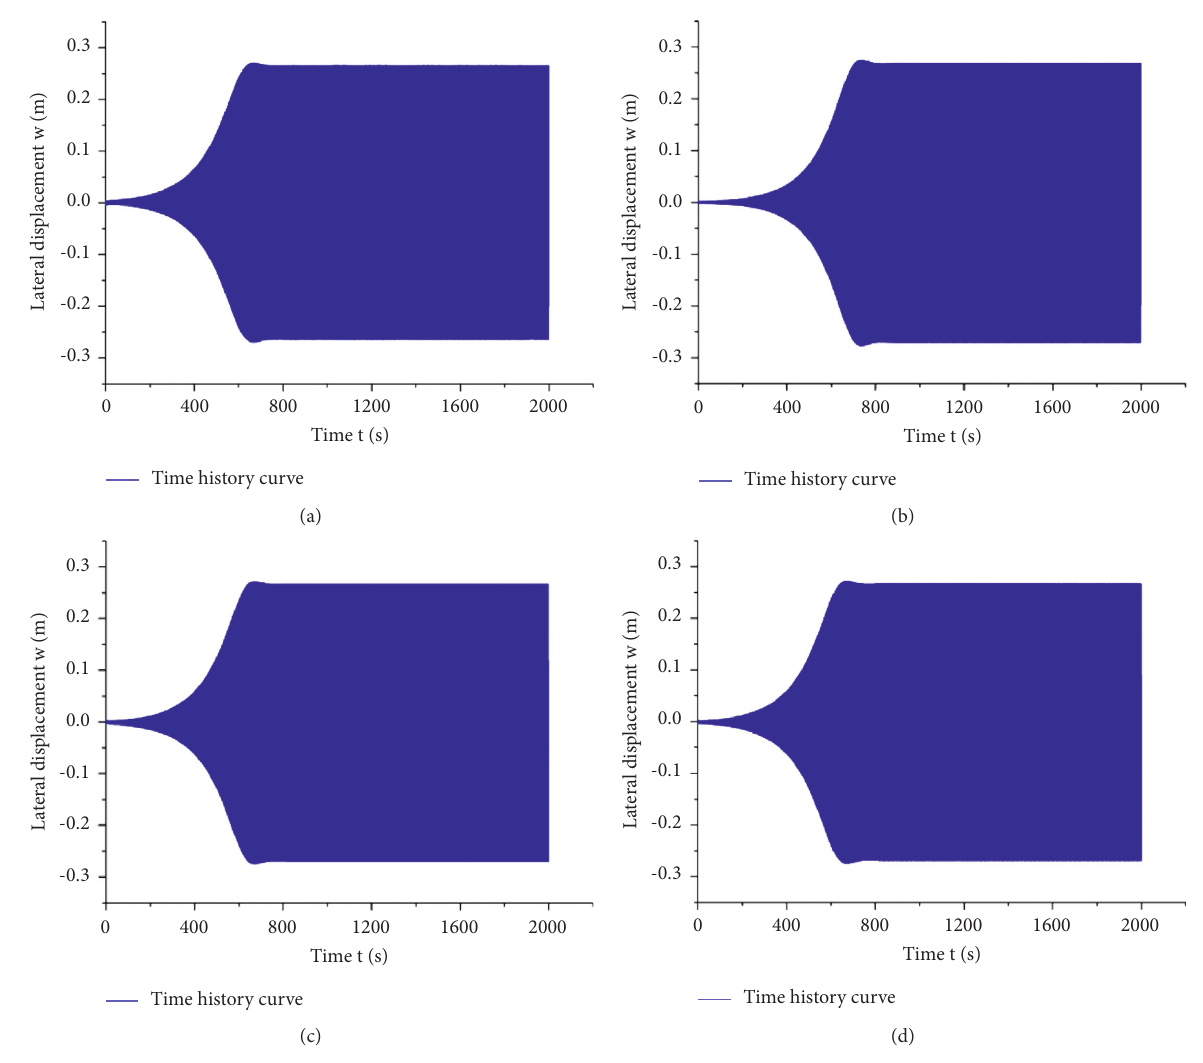
Figure 18: Lateral displacement in various conditions. (a) r � 0.2. (b) r � 0.5. (c) r � 1.0. (d)